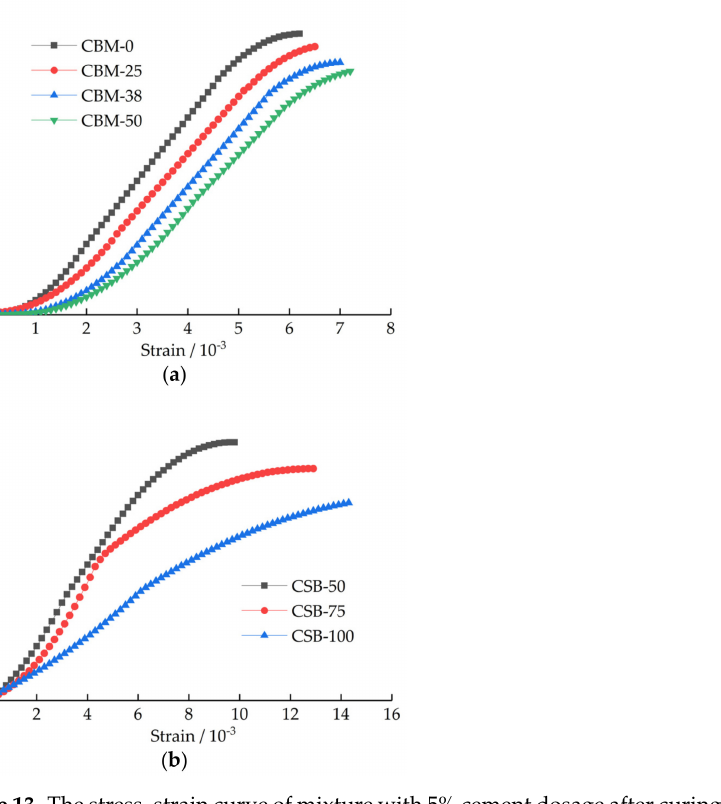
Figure 13. The stress–strain curve of mixture with 5% cement dosage after curing for 90 days. ( a ) CBM group. ( b ) CSB